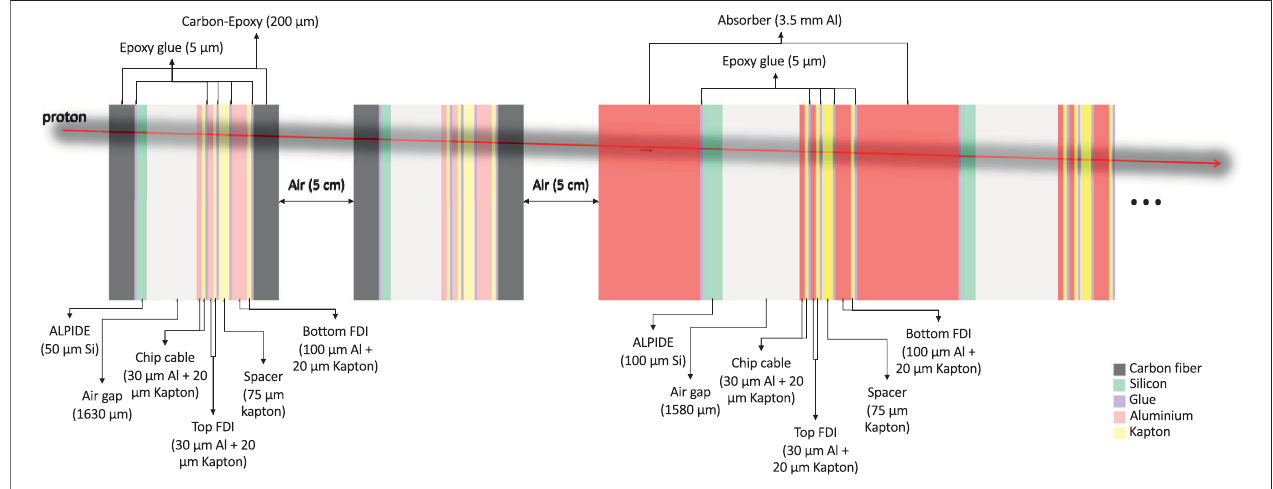
FIGURE9| Detectorgeometryconsistingofslabsapproximatingthe fi